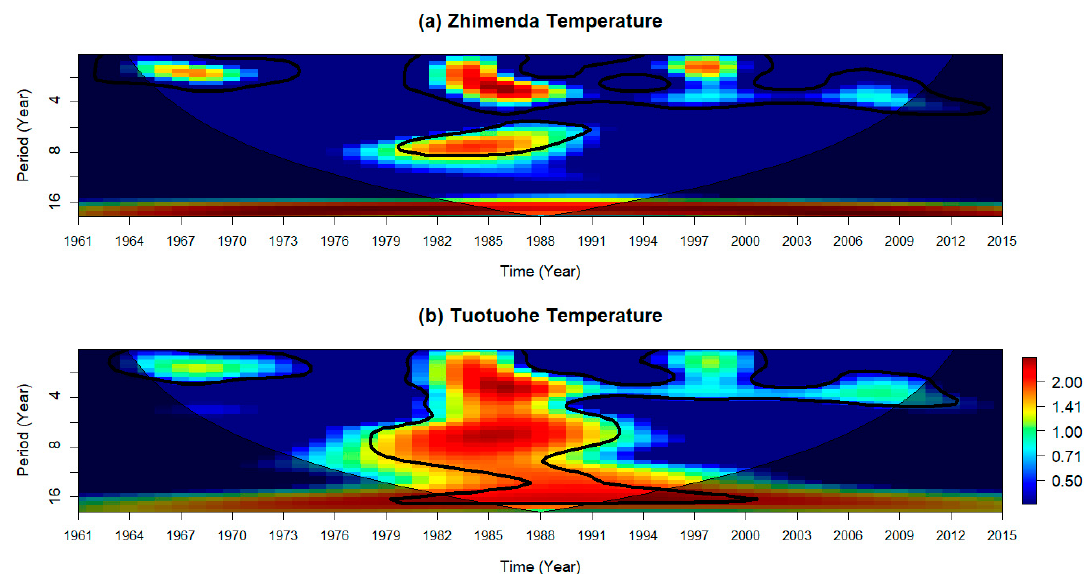
Figure 8. Wavelet power spectrum for annual areal averaged temperature for Zhimenda and Tuotuohe sub-basins during 1961–2015. The black line shows statistical significance at the 0.05 level.